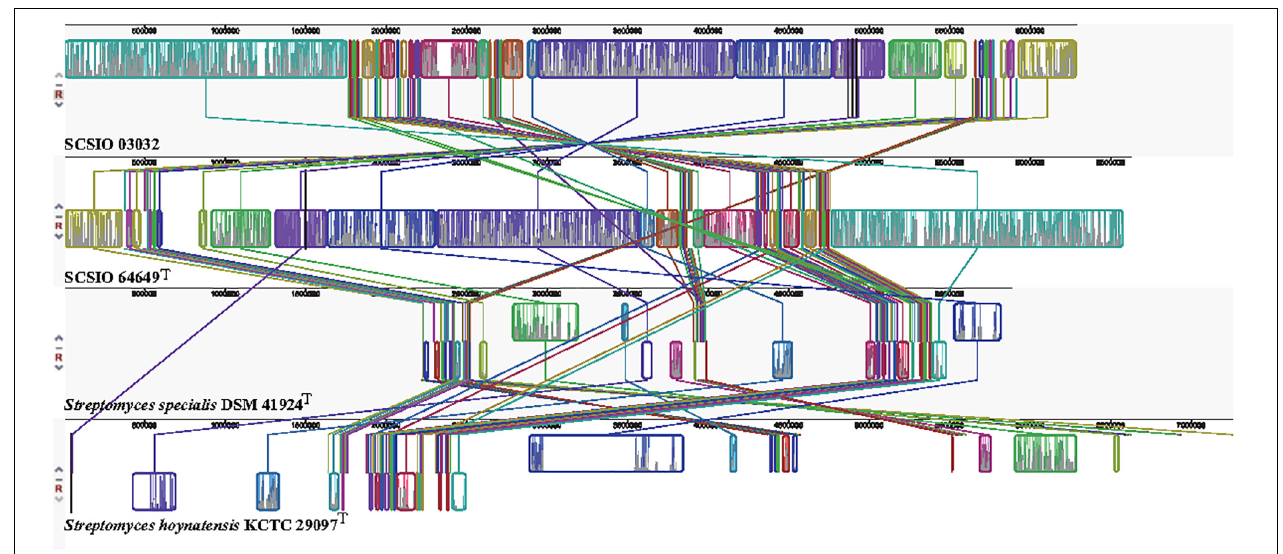
FIGURE 5 | Genome alignment between strains SCSIO 64649 T , SCSIO 03032, S. specialis DSM 41924 T , and S. hoynatensis KCTC 29097 T